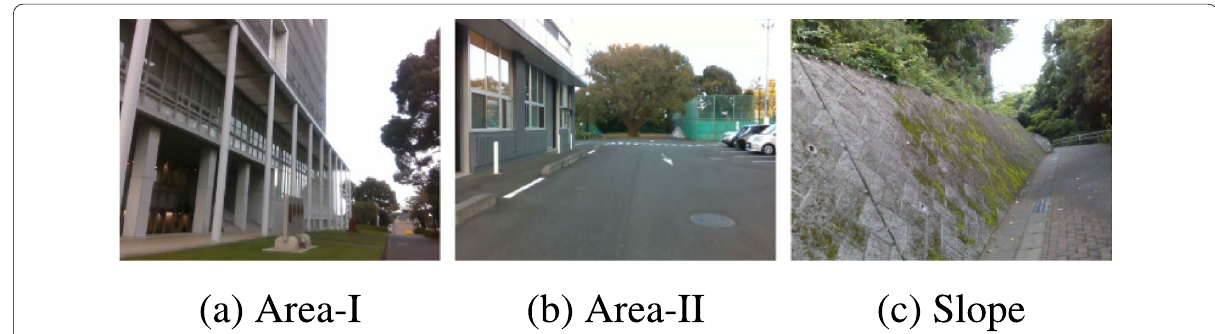
Fig. 8 Environments for collecting datasets. Dataset#3 was collected in ( a ). Dataset#4, 5 were collected in ( b ). Dataset#6 was collected in ( c )